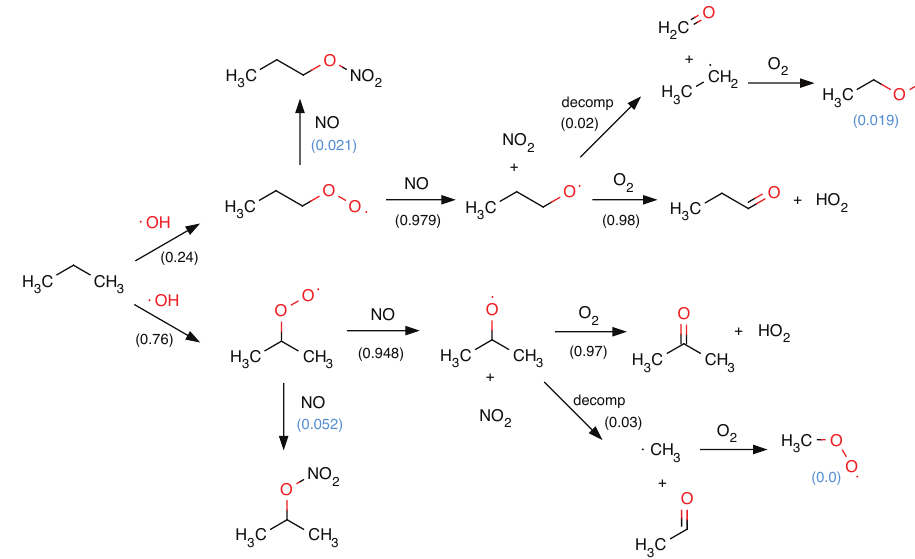
Figure B2. Propane oxidation by OH radical in the presence of